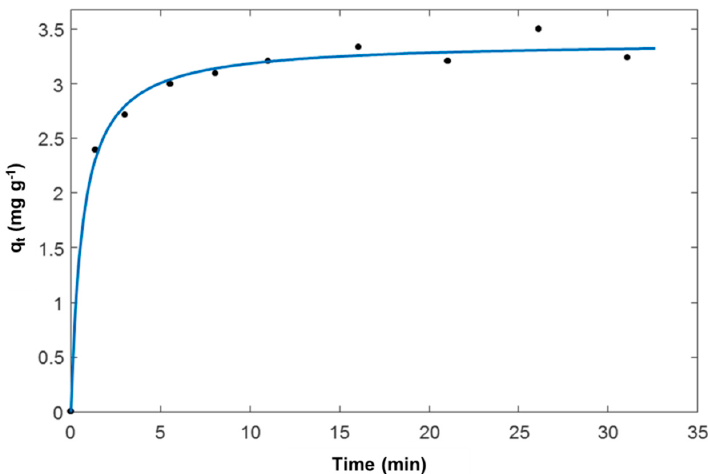
Figure 1. Adsorption kinetics of toluene (TOL) on Beta360: TOL uptake vs. contact time.